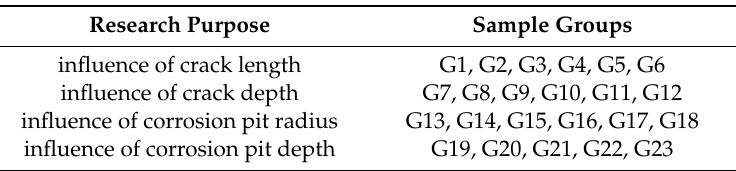
Table 6. Sample group classification.